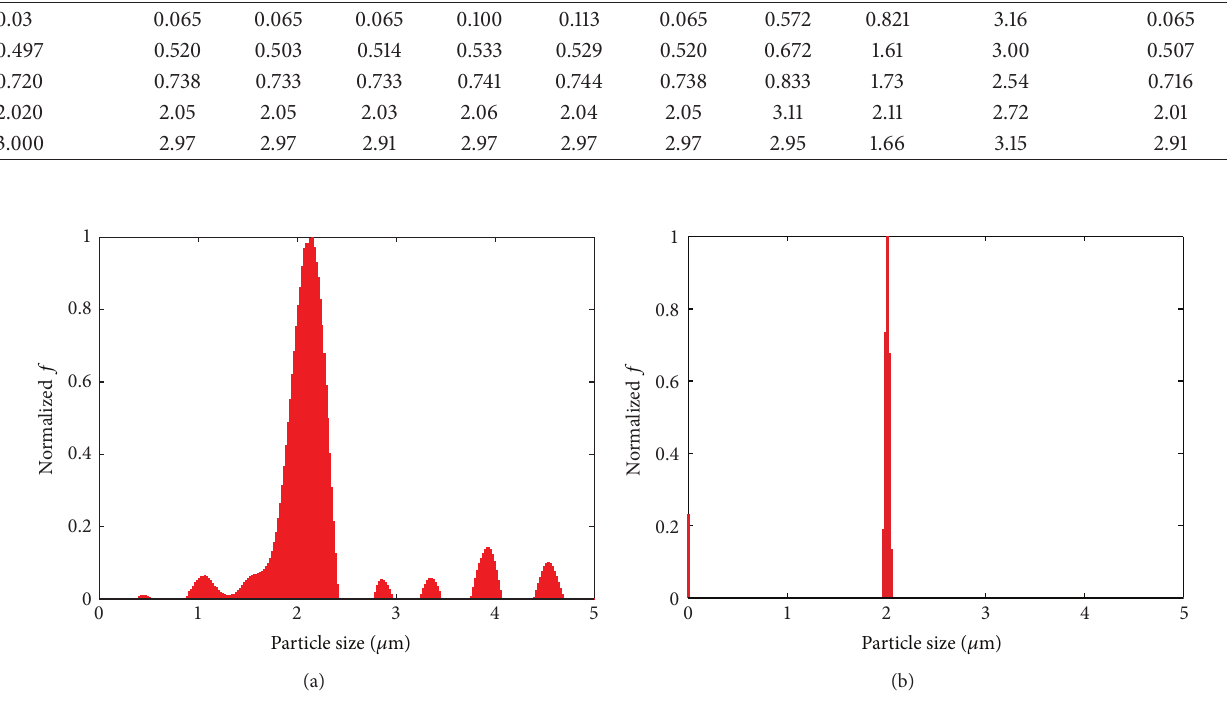
Figure 7: Retrieved particle size distribution of the polystyrene suspension for smoothing matrices 𝐻 1 and (a) TPR with applied modified = 2.02 𝜇 L-curve and (b) NNTPR for 250 size classes for 𝑥 nominal